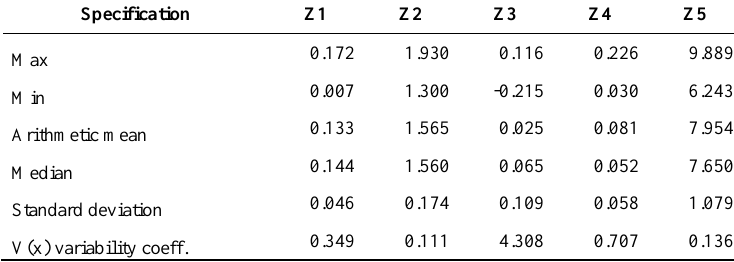
Table 3. The basic characteristic for selected diagnostic variables (Option1)